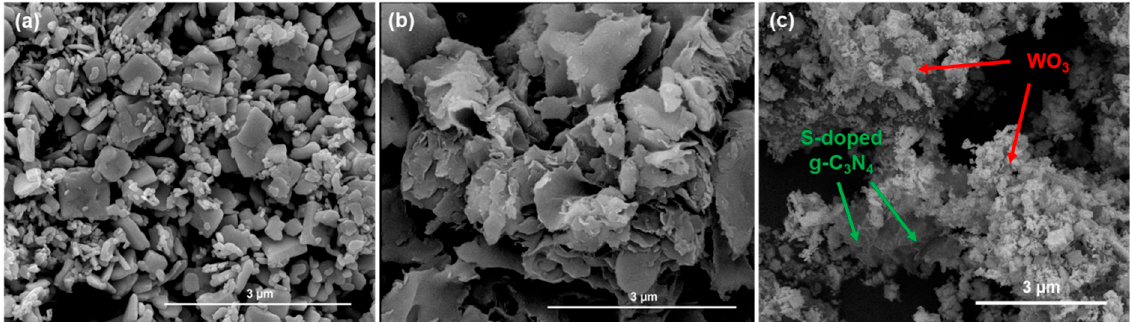
Figure 3. FTIR spectra of WO 3 /S-g-C 3 N 4 and single components.